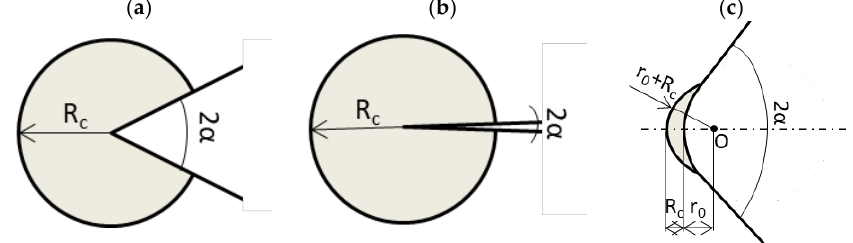
Figure 2. Control volume for sharp V-notch ( a ), crack case ( b ), and blunt V-notch ( c ) under opening mode I loading.